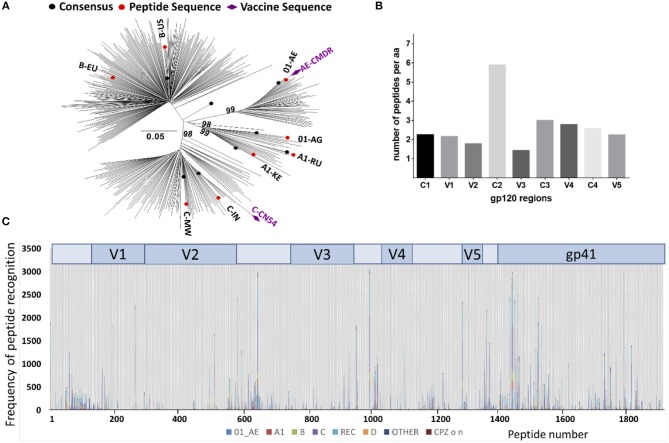
Peptide array design to cover recently transmitted global HIV strains. (A) Phylogenetic analysis of acute infection sequences (n = 350) from the Los Alamos database used for the selection of the eight isolates (in red) to design the peptide array. Purple diamonds indicate the isolates of the vaccine immunogens CMDR and CN54. Evolutionary analyses were conducted in MEGA6 (24) and the evolutionary history was inferred using the Neighbor-Joining method (25). The percentage of replicate trees (Bootstrap test 100 replicates) in which the associated taxa clustered together is shown above the branches (26). (B) Number of 15-mer amino acid (aa) sequences represented in the peptide array. The peptide array was aligned to the HxB2 sequence that was scanned with a sliding window of 11 aa using a three aa step. The Y-axis indicates the number of 11-mer aa sequences found in the array corresponding to a given 11-mer HxB2 window. (C) Peptide recognition amongst the known Los Alamos database HIV-1 sequences. 2,078 peptides produced 471,597 complete homology hits amongst 10,956 virus isolates. The Y-axis indicates the number of hits per peptide position, each subtype represented by a different color.